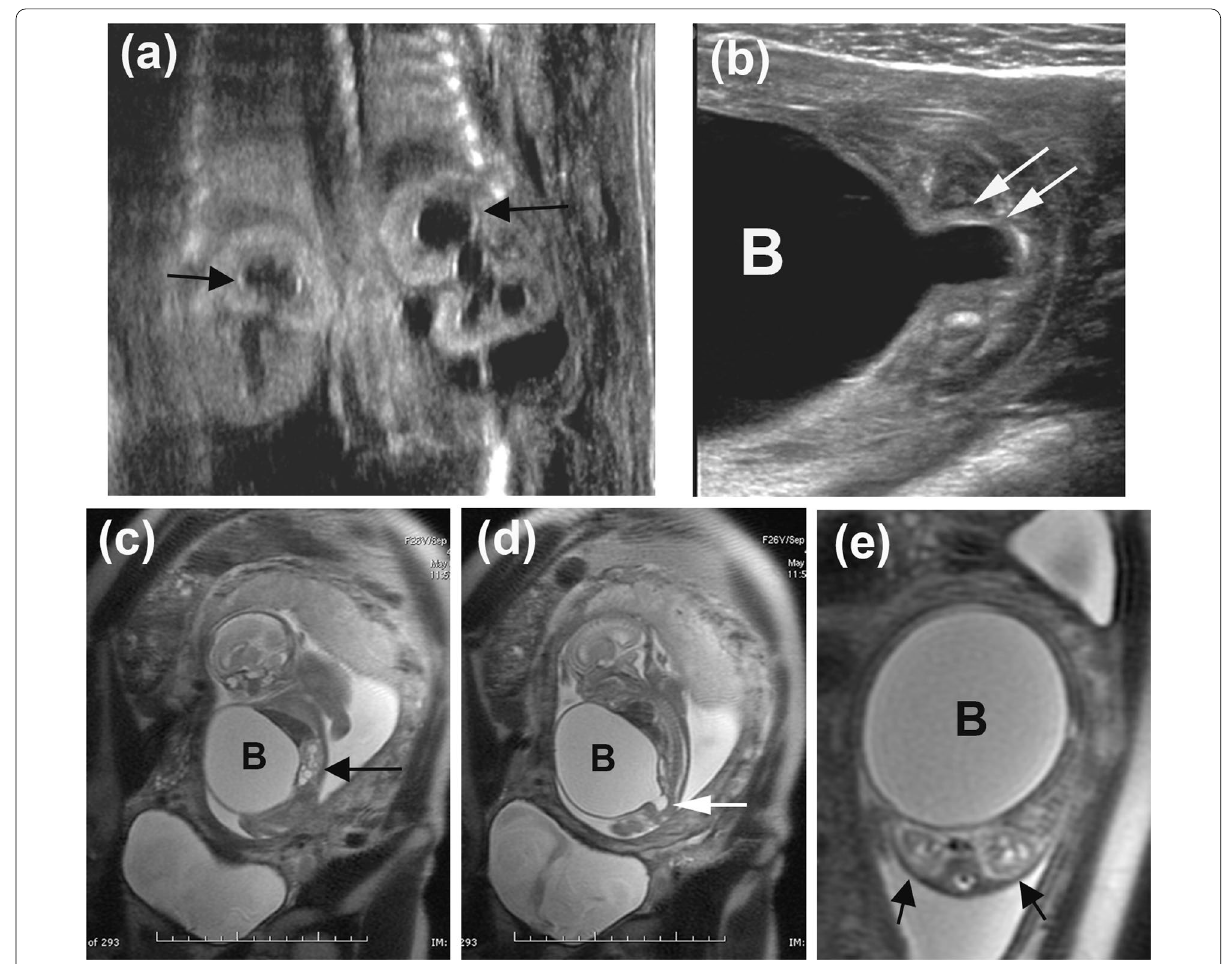
Fig. 2 Prenatal ultrasound a , b and fetal MRI c , d , e showing bilateral hydronephrosis (black arrows), distended bladder (B) with dilation of the posterior urethra “the keyhole sign” (white arrows), suggestive of the diagnosis of posterior urethral